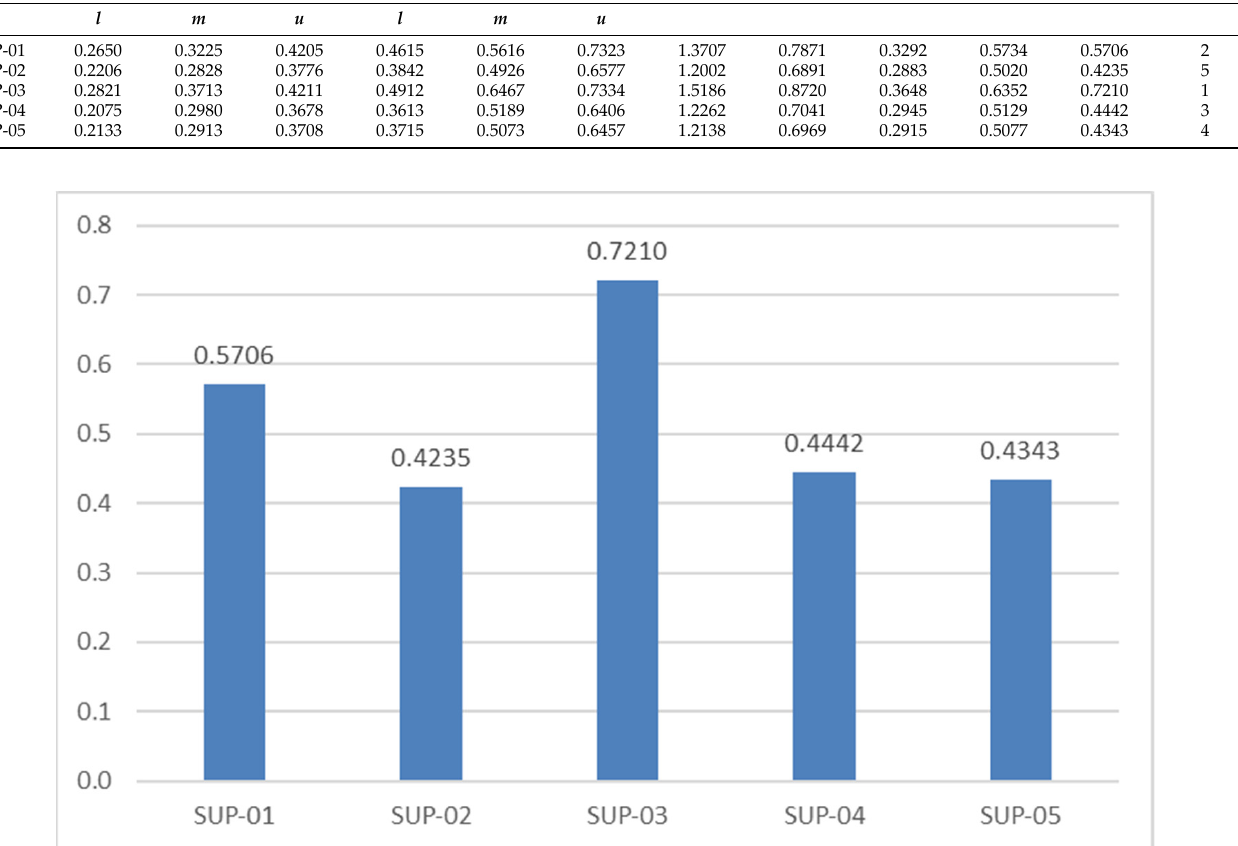
Figure 4. The final supplier ranking.